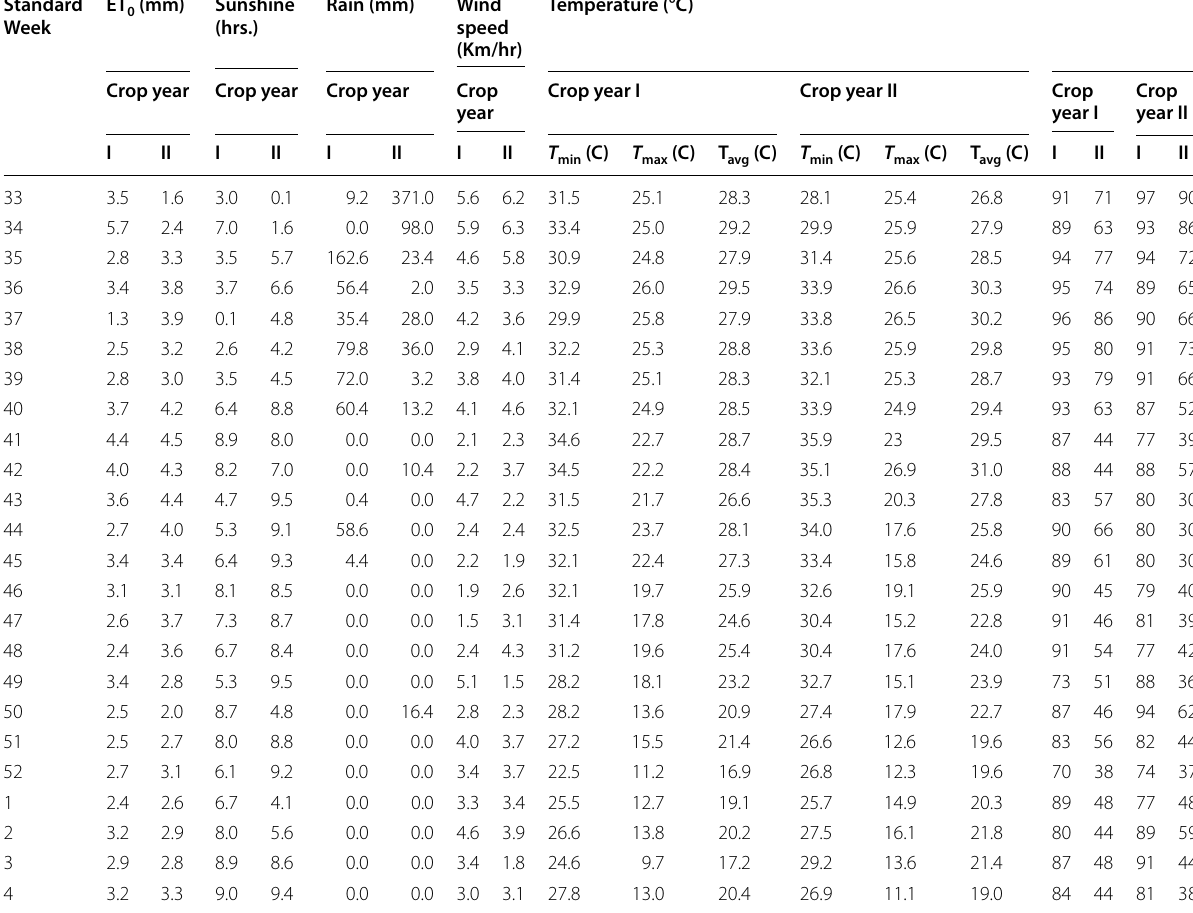
ET 0 (mm)-evapotranspiration, T min (°C) Minimum temperature, T max (°C) Maximum temperature, T avg (°C) Average temperature, RH avg (%)-average relative humidity